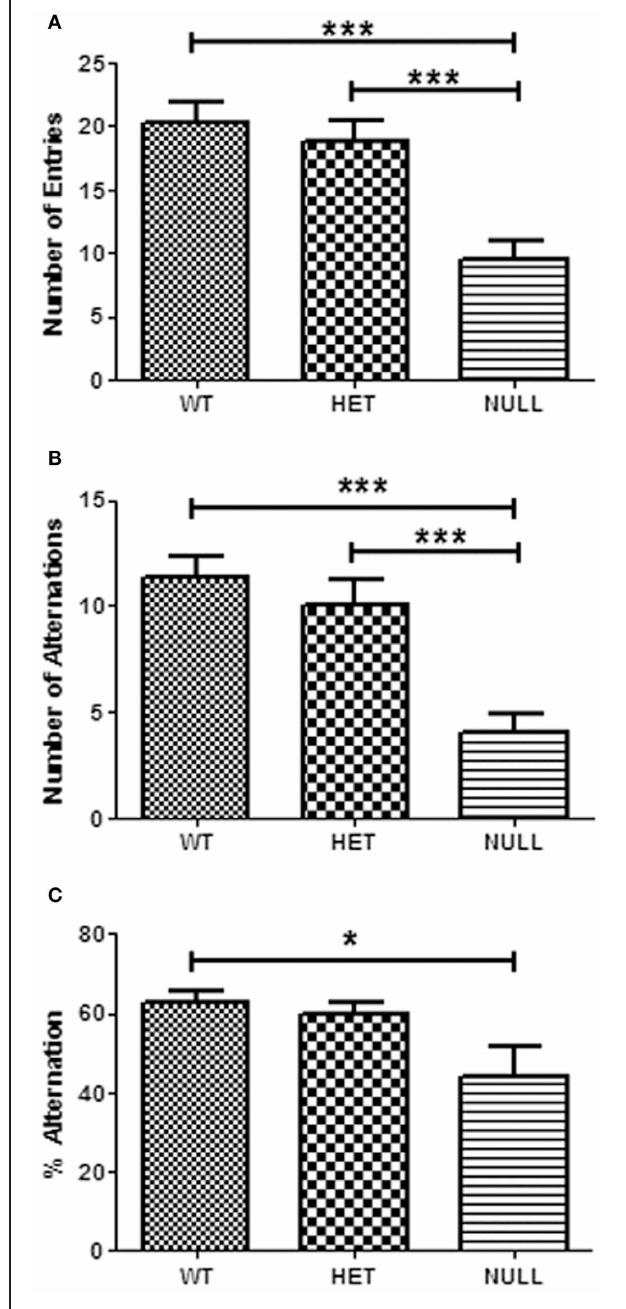
FIGURE 5 | Y-maze test. In this test of spatial working memory, the reduced number of arms entered by G α q knockout mice compared to wildtype and heterozygous littermates again reveals a hypoactive phenotype (A) . In addition, acquisition of this spatial task was severely impaired in G α q knockout mice which exhibited a significant reduction in the number of spontaneous alternations ( B ; F ( 2 , 44 ) = 14 . 42, p < 0 . 001) and percentage of alternations ( C ; F ( 2 , 44 ) = 4 . 44, p < 0 . 05 between wildtype and null) in this task. Percentage of alternations was determined by dividing the number of alternations by the number of possible alternations [(# total arm entries − 2) × 100], thereby taking into account the locomotor phenotype of G α q knockout mice. Each column represents the average of 12–18